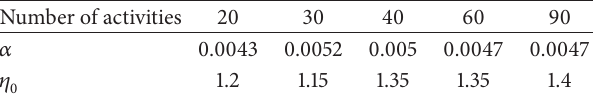
Table 1: The parameters for the generated problem set. Table 2: The tuned values for 𝛼 and 𝜂 0